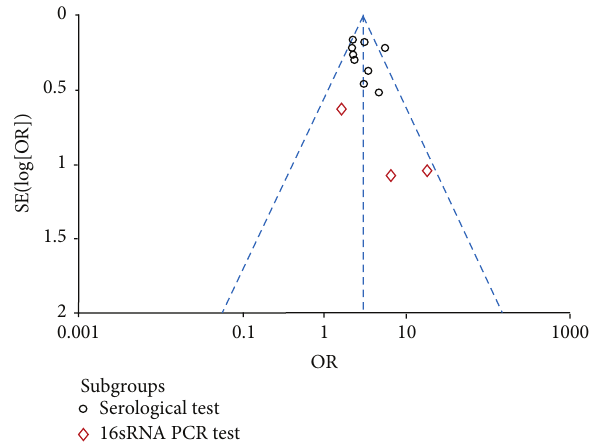
Figure 5: Funnel plot to explore publication bias. The graphical funnel plot of the 12 published studies appears to be